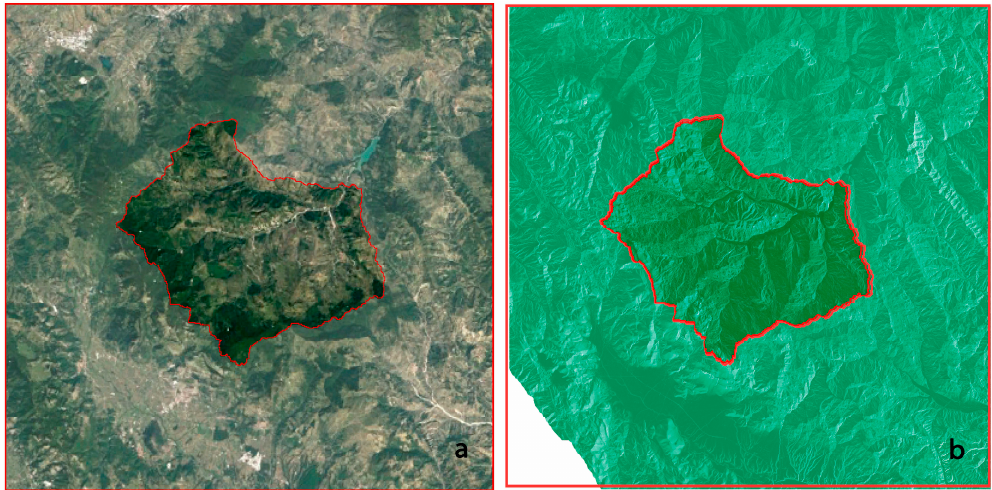
Figure 4. Relief map: ( a ) by Google™ Earth Pro platform, ( b ) by QGIS™ software.